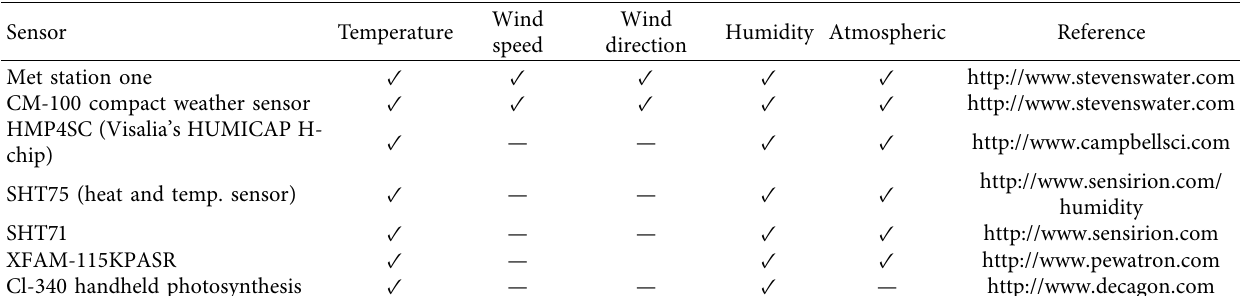
Table 4: Sensors used for irrigation control systems in farming domains